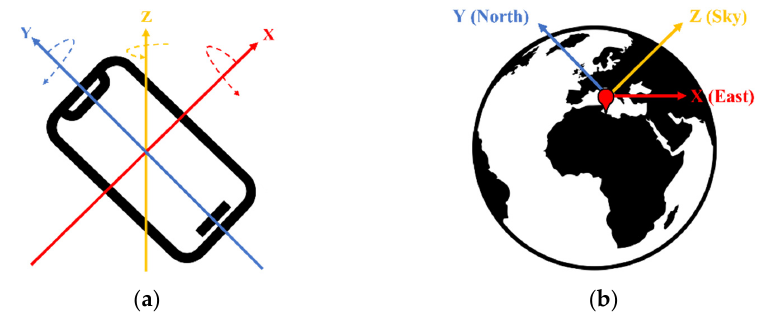
Figure 4. Coordinate system ( a ) Device oriented coordinate ( b ) Earth oriented coordinate.